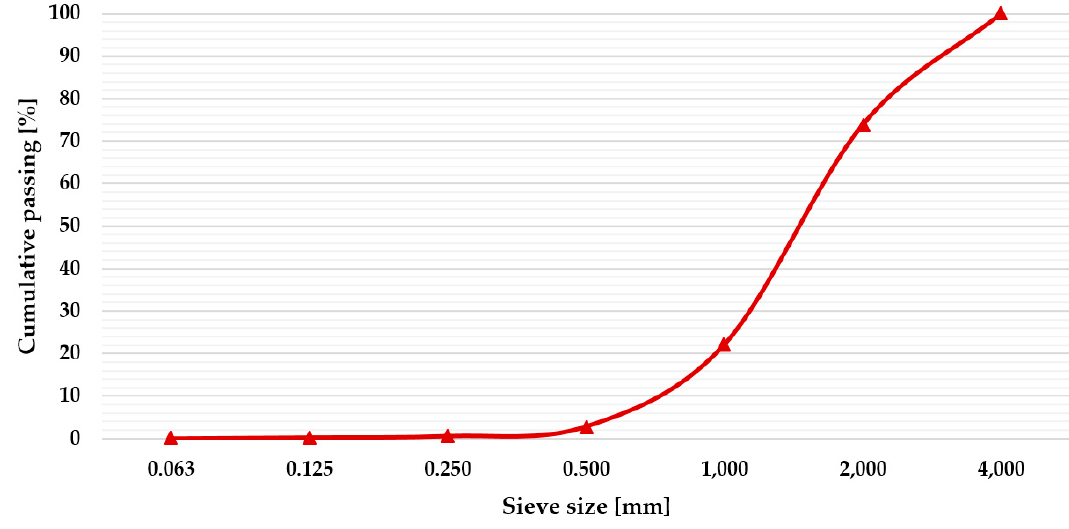
Figure 3. Particle size distribution of crushed discs used in the Figure 3 . Particle size distribution of crushed discs used in the mixtures.